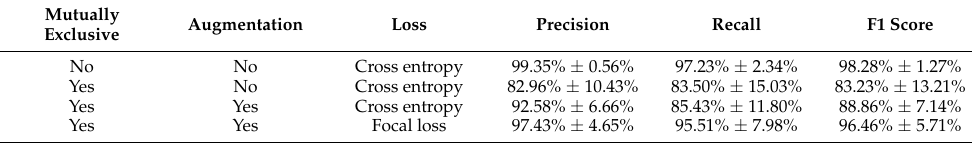
Table 3. Performance of Experiment 1 and Experiment 2A-C of age groups